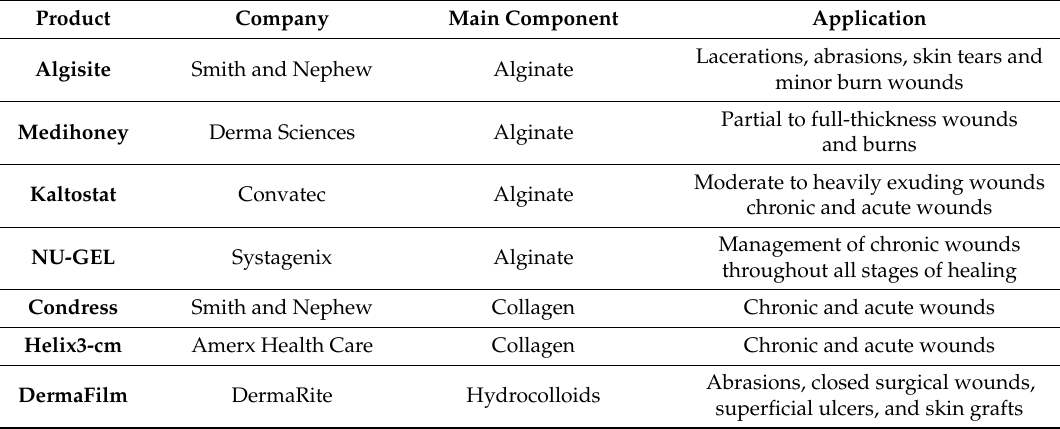
Table 2. Some examples of commercial hydrogel-based wound dressings